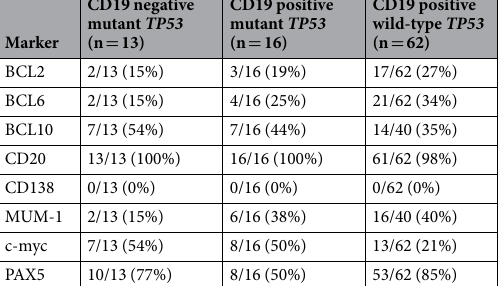
Table 2. Summary of the B-cell and lymphoma marker distribution amongst CD19 and TP53